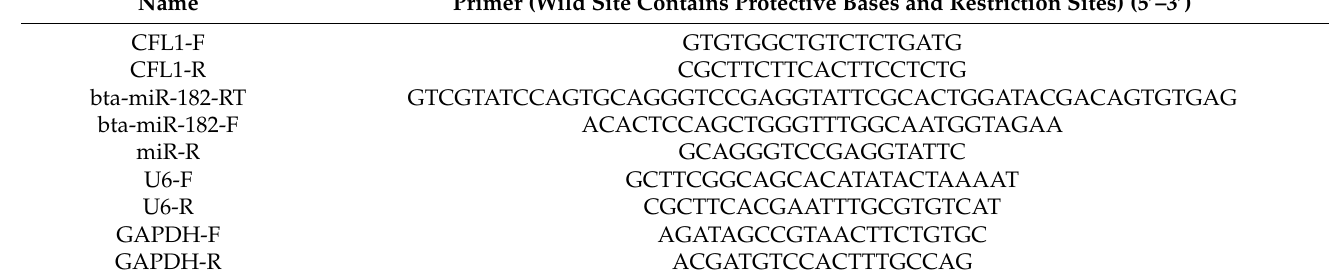
Table 3. Primer information for